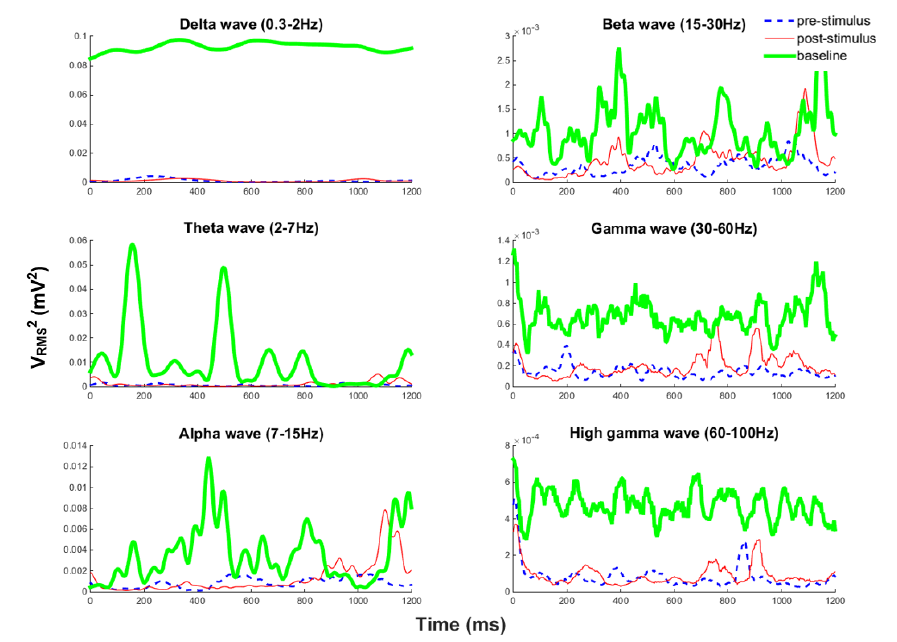
Figure 7. Averaged pre-stimulus and post-stimulus band power changes compared with the no stimuli baseline